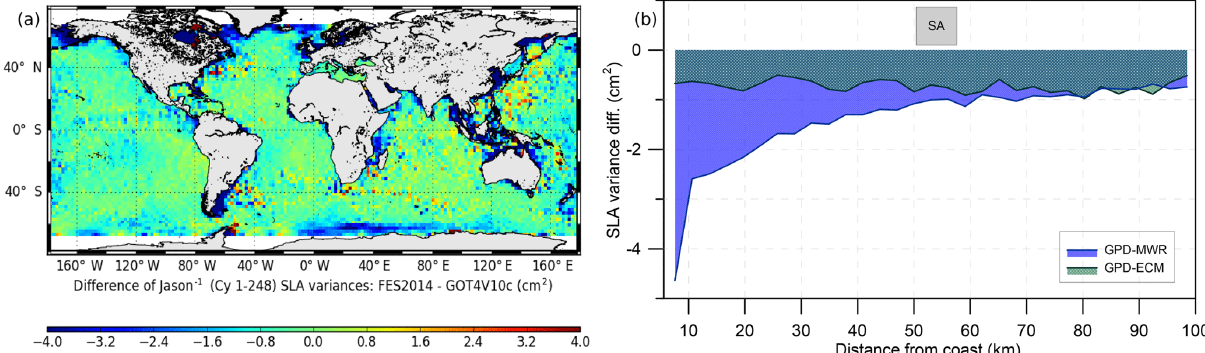
Figure 8. (a) Sea level variance differences for Jason-1 cycles 1-248 (2002–2008) using FES2014 and GOT4.10c ocean tide corrections successively. (b) SARAL/AltiKa sea level variance difference calculated with different wet troposphere corrections (green compares GPD + with ECMWF operational model and purple with the initial version of the radiometer correction) as a function of the coastal